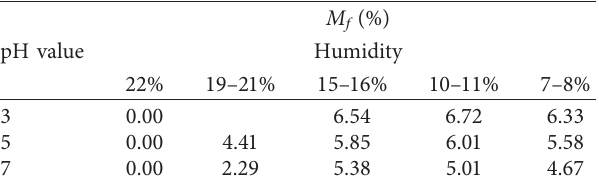
Table 6: The average crack width of the sample under four-time cyclic